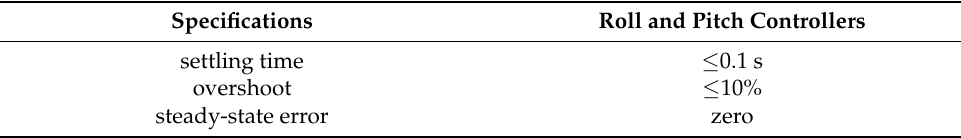
Table 2. Controller design